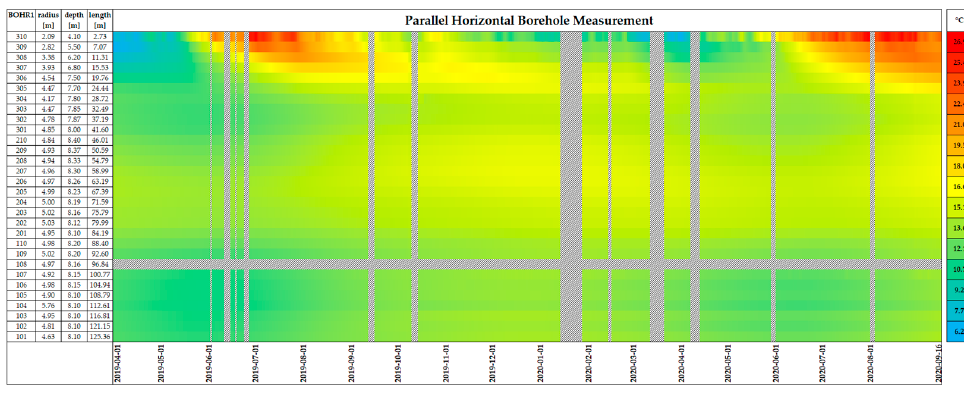
Figure 18. Parallel borehole temperature profile of BOHR 2.